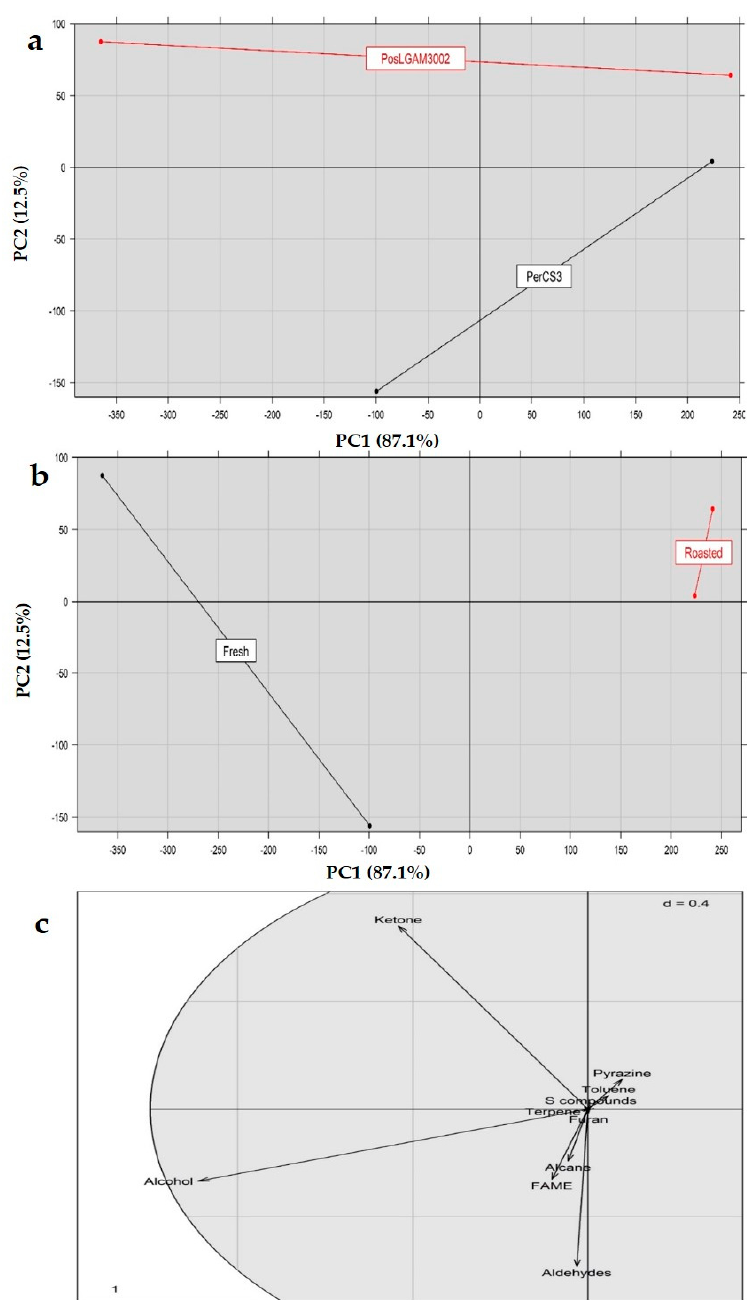
Figure 4. Score plot of principal component analysis and discrimination on the basis of classes of volatile compounds detected in fresh vs. roasted Pleurotus mushrooms at ( a ) species/strain level ( P. ostreatus vs. P. eryngii ) and ( b ) treatment (fresh vs. roasted) level, as well as their ( c ) loadings (Pos: P. ostreatus ; Per: P. eryngii ).